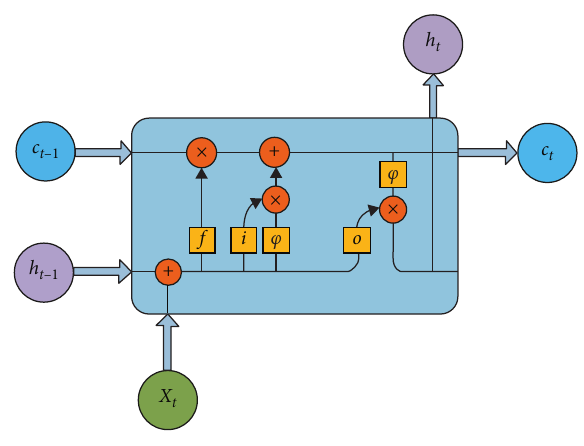
Figure 1: Structure of